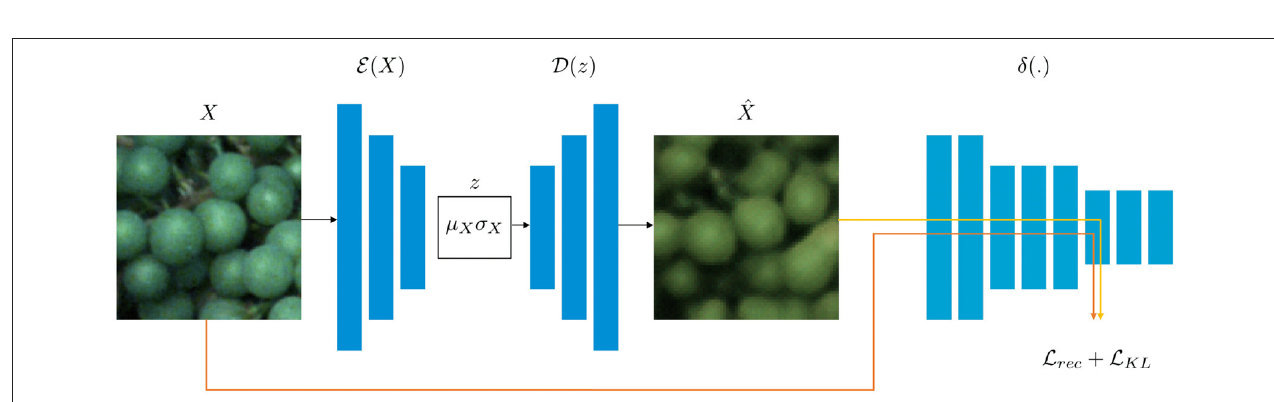
FIGURE 3 | Proposed pipeline for the identification of anomalous grapevine berries using a VAE. Input images are segmented using a CNN (Zabawa et al., 2020) classifier which provides a semantic segmentation of berries and background. The resulting segmentation masks represent regions of interest containing bunches of berries. In these regions, we extract patches and feed them into a VAE. The deviation between reconstructed and input image is measured pixel-wise using a defined metric and used to calculate heatmaps highlighting anomalous image regions considered as damaged berries.